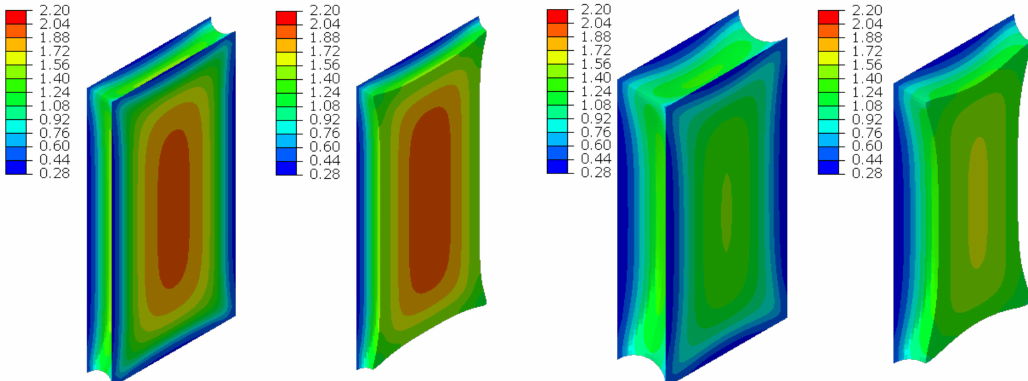
Figure 2. Deformations for scaling factor 1.0 and Cauchy stresses σ z in MPa for total load level. The width of the gap is equal to 1.0 cm, left graphics, and 2.0 cm, right graphics. Views on connection, first and third columns, or central plane, second and fourth